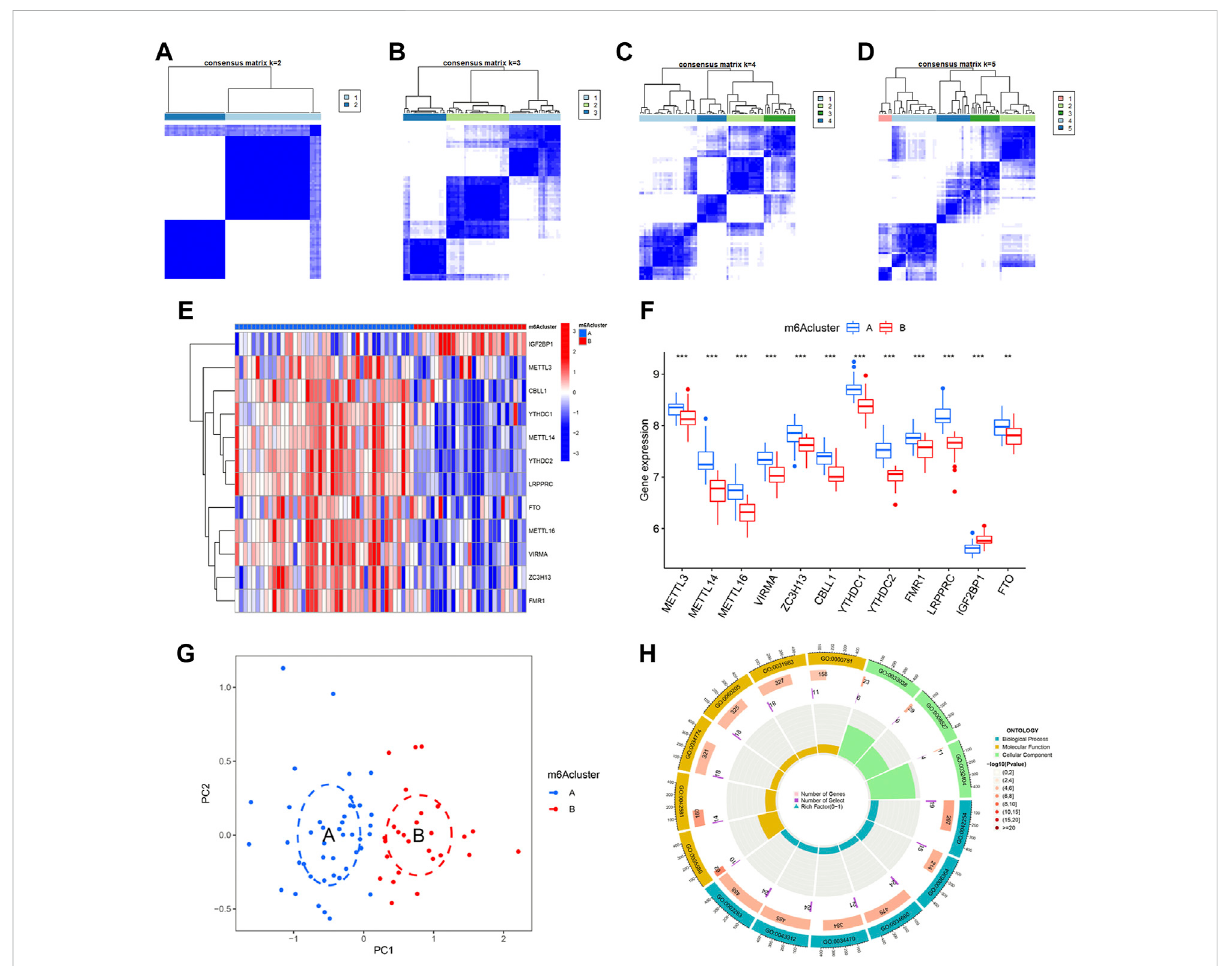
FIGURE 6 Consensus clustering of 12 signi fi cant m6A regulators in IPF. (A – D) Consensus matrices with cluster count from 2 to 5 showing an optimal cluster (clusterA and cluster B) with k = 2. (E) Expression heatmap in clusterA and clusterB. (F) Differential expression histogram in clusterA and clusterB. (G) Principal component analysis based on 12 signi fi cant m6A regulators showing a notable distinction between clusterA and clusterB. (H) Gene ontology enrichment showing potential biological functions of 402 m6A-related differentially expressed genes (DEGs) on